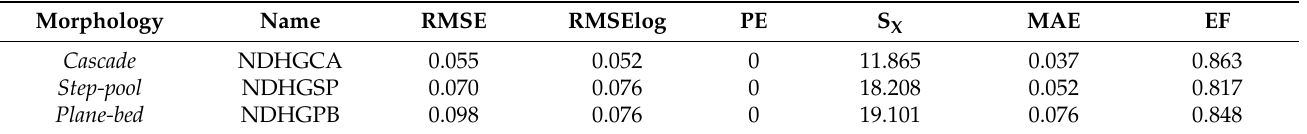
Table 6. Comparison of proposed NDHG equations with previously best-performing empirical equations.